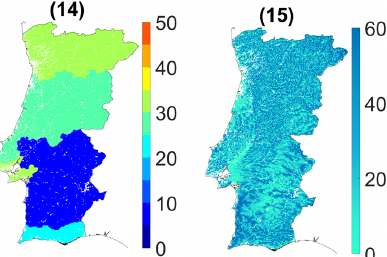
Figure 3. As in Fig. 1, but with respect to the adaptive-capacity